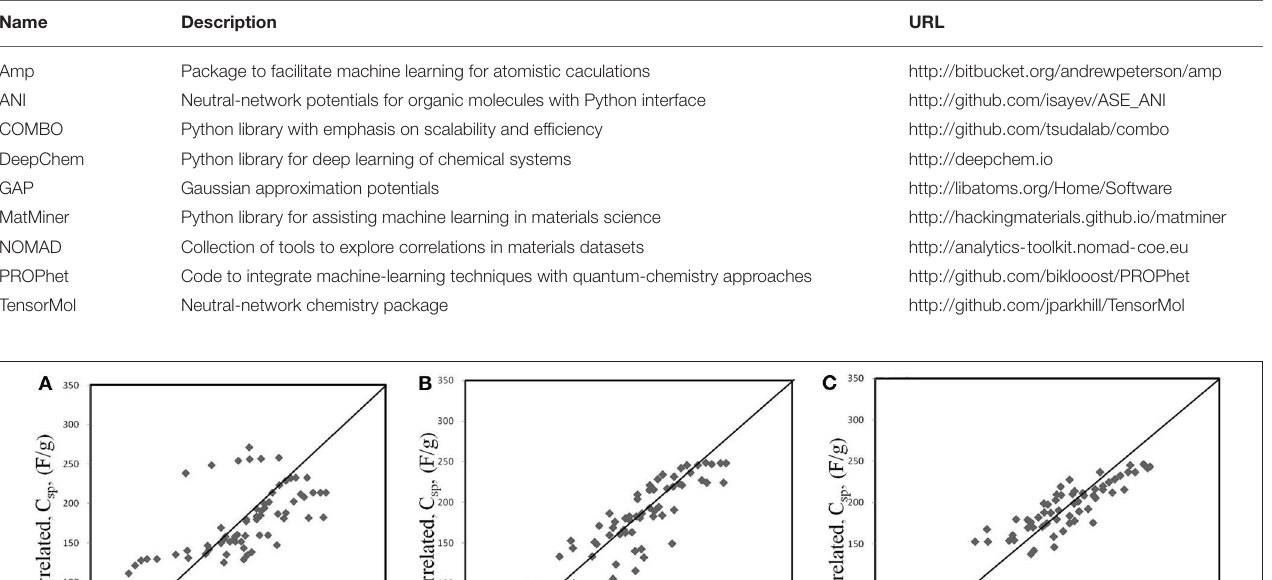
TABLE 1 | ML tools for molecular and materials which are public and available to use from Butler et al. (2018).